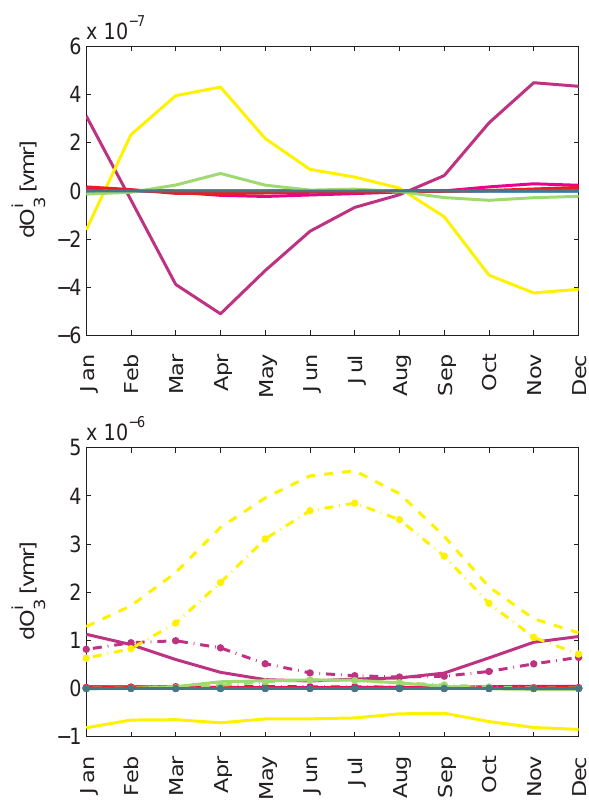
Fig. 8. Climatology (2000-2009) of the annual cycle in the net monthly tendencies dO i 3 in ozone (top) and in the lower panel the tendencies due to transport [ T i ] (solid line), production [ P ] (dashed line) and destruction (dash-dotted line) in the northern mid-latitudes. Yellow lines are local mid-latitude ozone, purple lines tropical ozone.